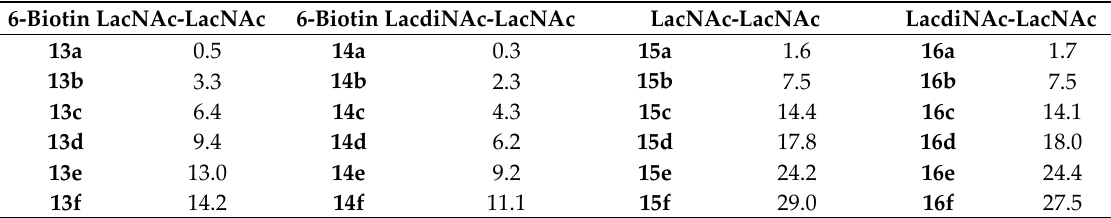
Table 3. Neo-glycoproteins used in SPR measurements. Biotinylated and non-biotinylated LacNAc- and LacdiNAc-terminated tetrasaccharides conjugated to BSA were used as Gal-3 ligands in SPR measurements. The numbering and modification degree of each neo-glycoprotein are shown. 6-Biotin LacNAc-LacNAc 6-Biotin LacdiNAc-LacNAc LacNAc-LacNAc